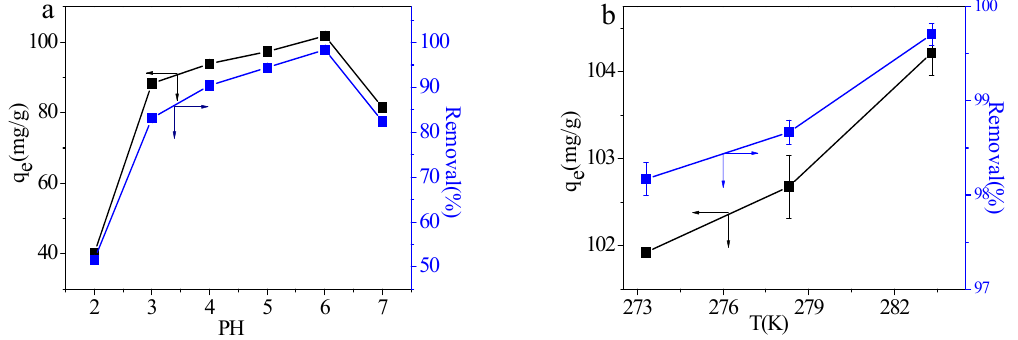
Figure 7. The effect of the Pb(II)-solution pH ( a ) and reaction temperature ( b ) on Pb(II) adsorption on MIL-125-CS beads.